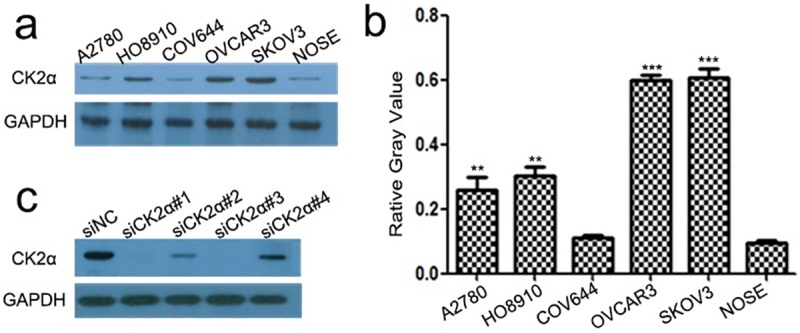
The expression level of CK2α protein in human EOC cell lines as evaluated by western blotting and the knockdown effect by siRNAs against CK2α.(a) CK2α protein was up-regulated in A2780, HO8910, OVCAR3, and SKOV3 cells (particularly in OVCAR3 and SKOV3 cells), but not in COV644 cells, compared with primary NOSE cells. (b) Histogram plotted with six relative gray values from Fig 1A. Each cell line was conducted in triplicate. **P<0.01 vs. NOSE; ***P<0.001 vs. NOSE. (c) Among the four tested siRNAs against CK2α, siCK2α#1 and siCK2α#3 showed higher knockdown efficiencies in OVCAR3 cells, compared with siNC (NC: negative control).